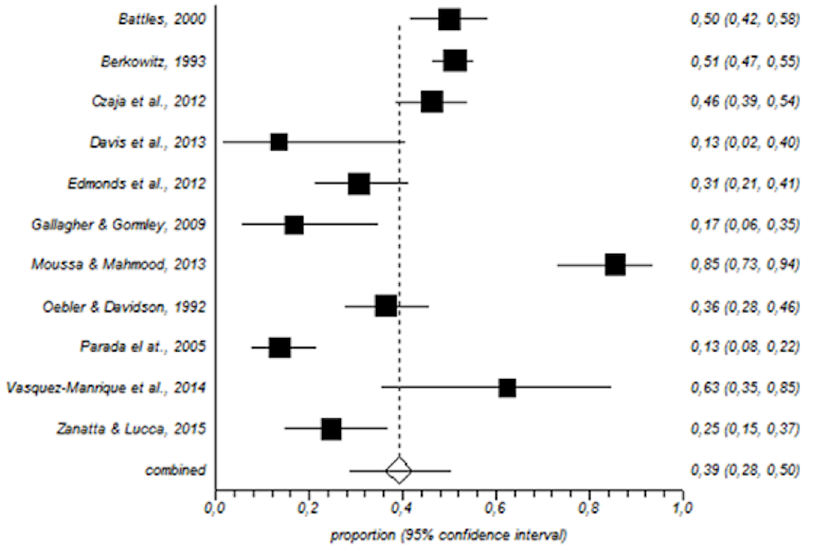
Fig 4. Forest plot for low personal